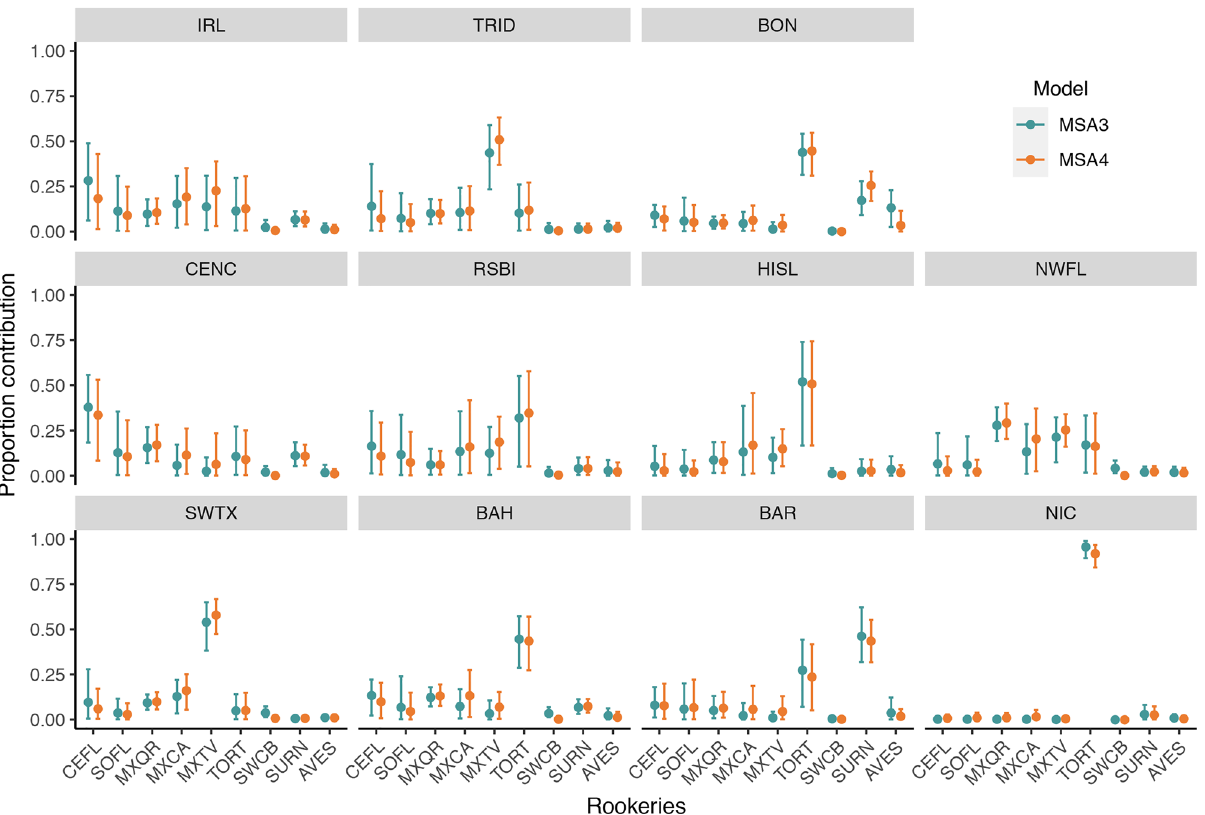
Figure 3. Mixed stock-centric estimates comparing different source sizes. Filled dots represent the mean estimate, and vertical bars 95% credible intervals. MSA 3 “historical” source size. MSA 4 “recent” source size. Asterisk: rookeries with evidence of a difference in contribution in response to source size variation. See Fig. 1 for site abbreviations.